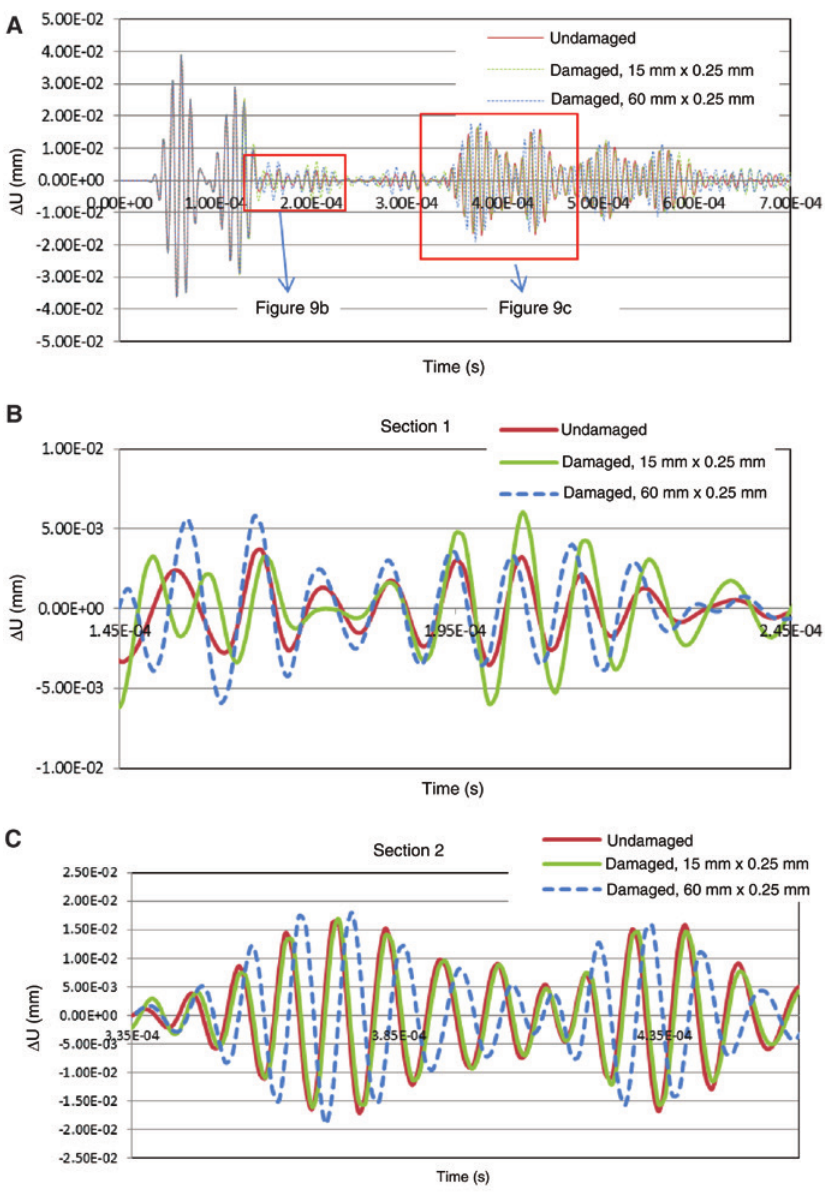
Figure 9: Wave package